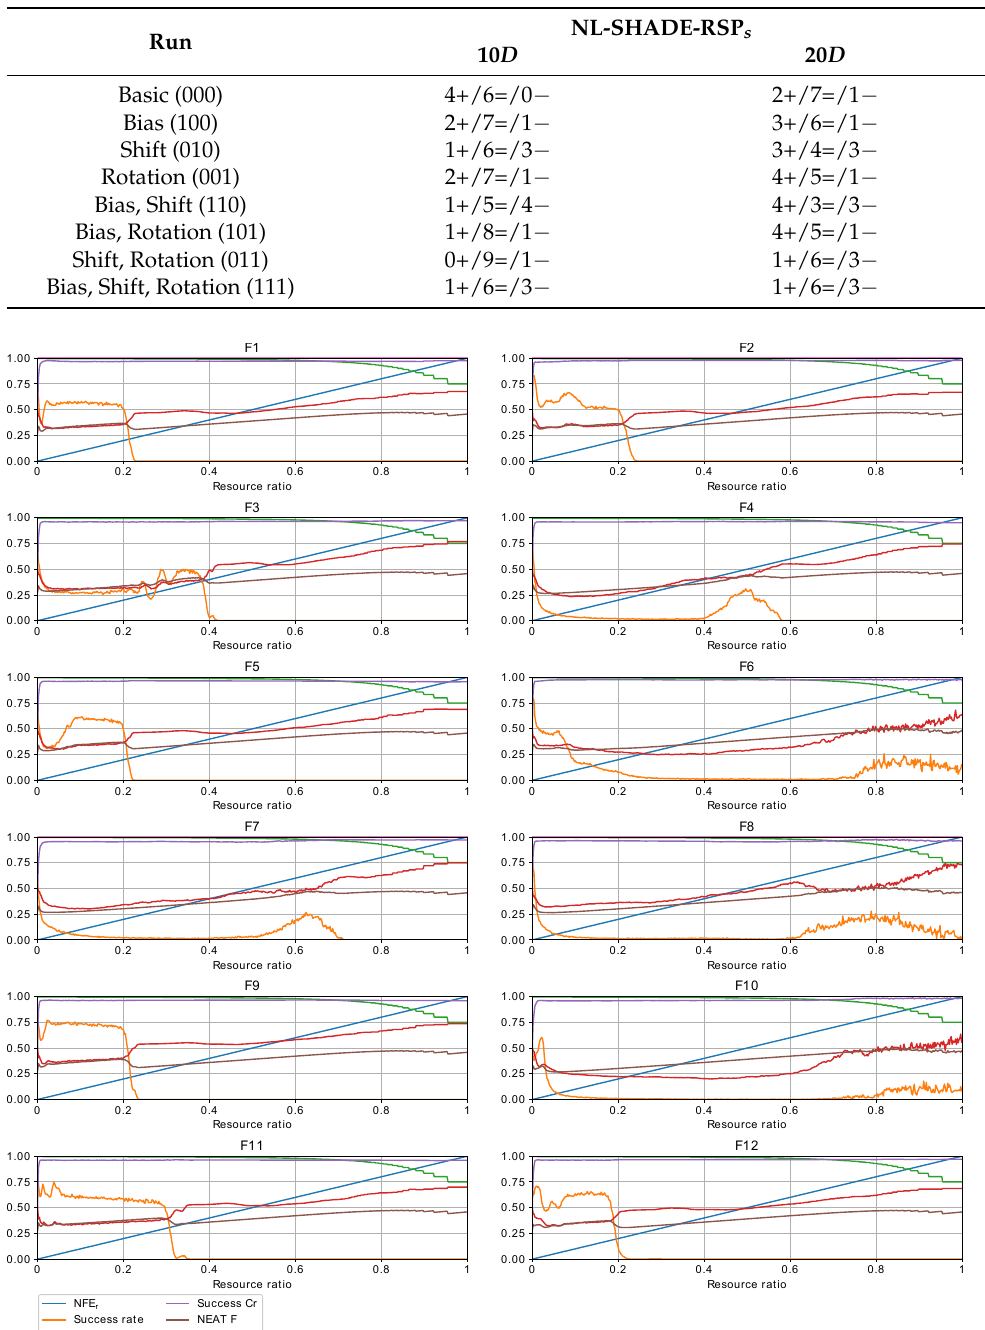
Table 4. Comparison of HA-NEAT-DBM heuristics on different benchmarks of CEC 2021, Mann–Whitney tests, run 49.